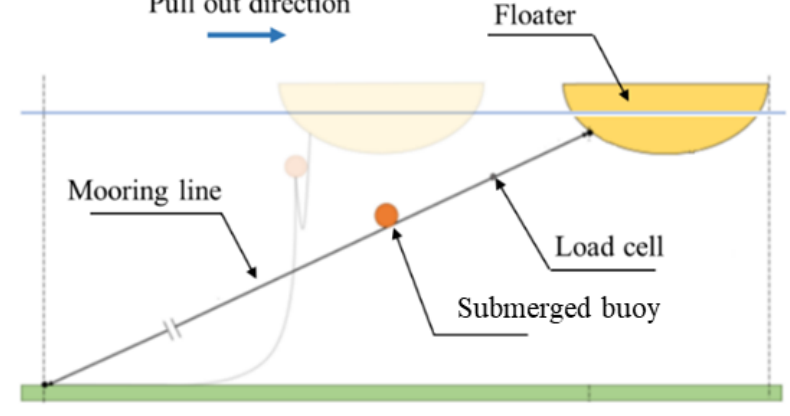
Figure 10. Pull-out test